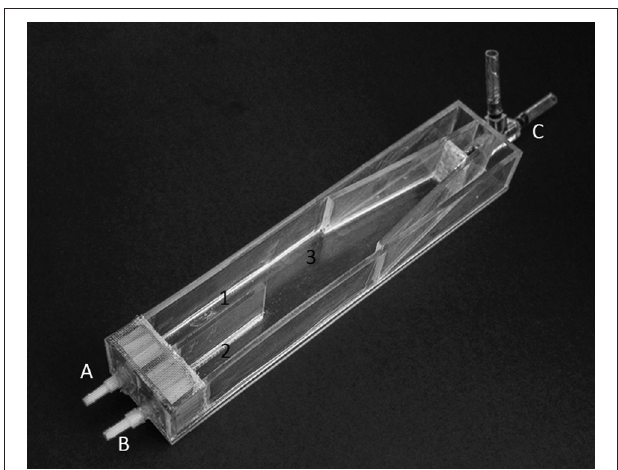
FIGURE 1 | Choice-chamber used to test the response of Sparus aurata larvae to odor cues along ontogeny. Legend: A, inlet hose 1; B, inlet hose 2; C, outlet hose; 1, choice-lane 1; 2, choice-lane 2; 3, area where larvae were placed at the beginning of each trial, and also the area where unresponsive behavior is